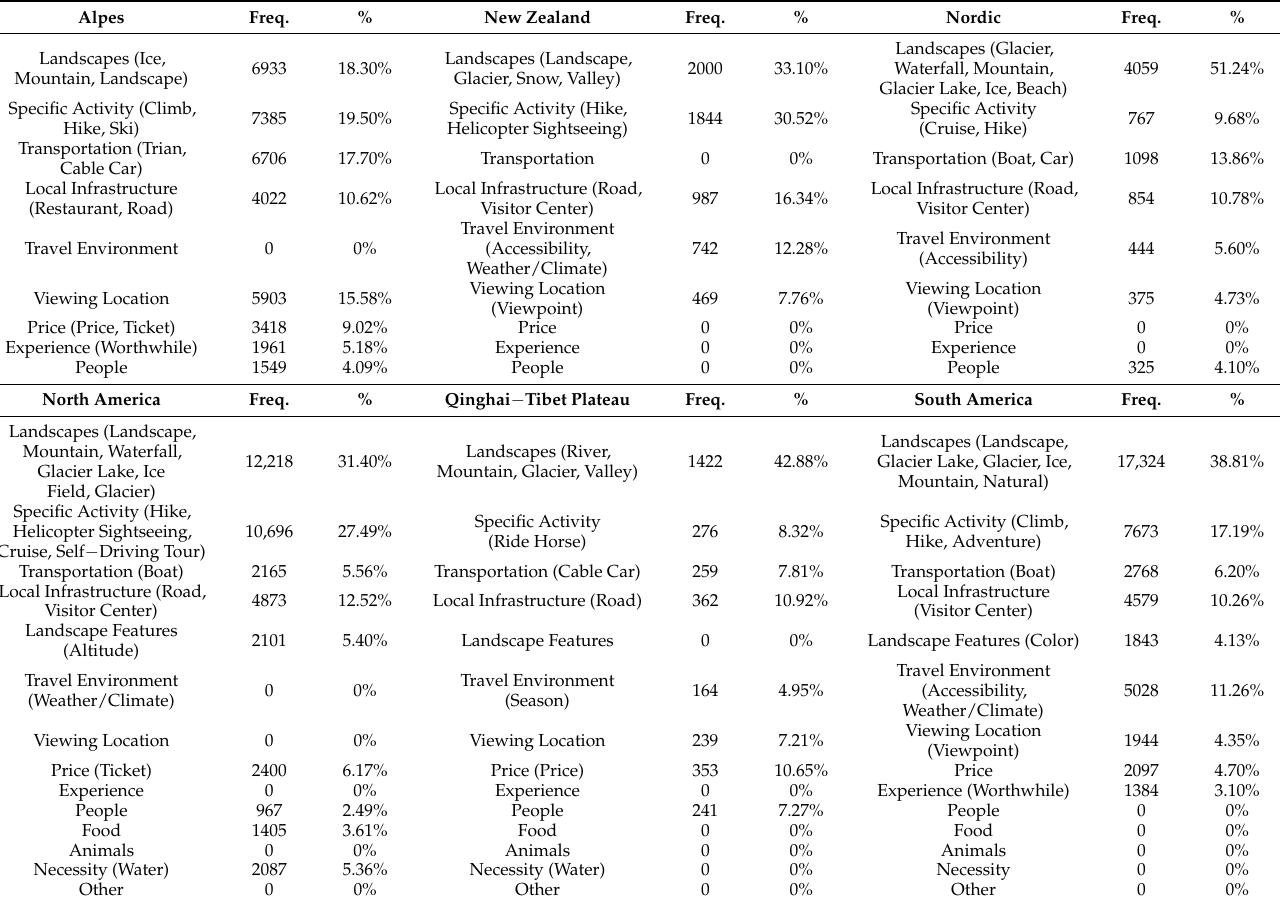
Table A4. Regional image of glacier tourism